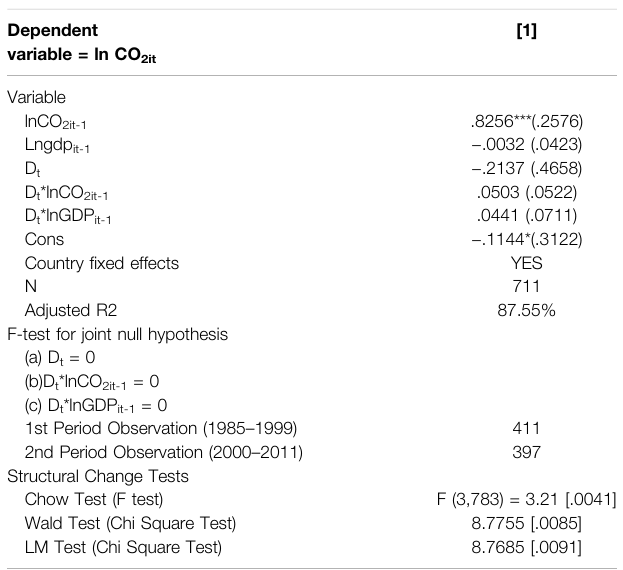
TABLE 2 | Chow Test for structural stability. TABLE 3 | Summary